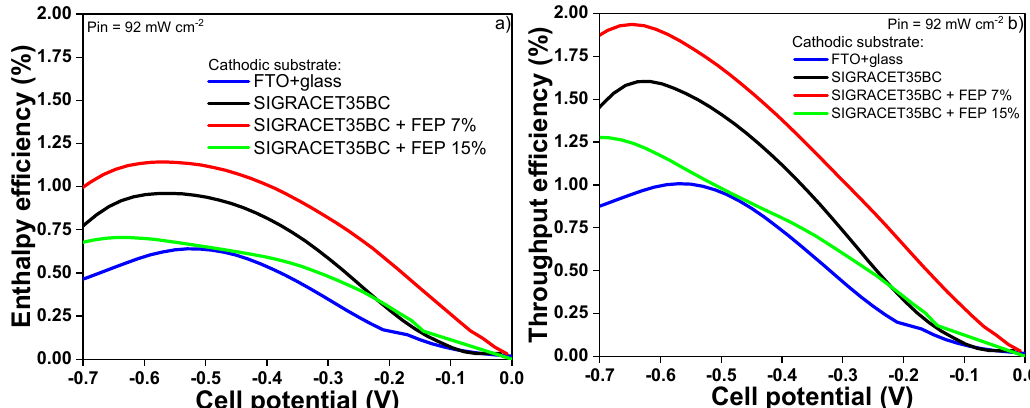
Figure 7. PEC enthalpy efficiency ( a ) and throughput efficiency ( b ) as a function of cell potential for various photocathode substrates.